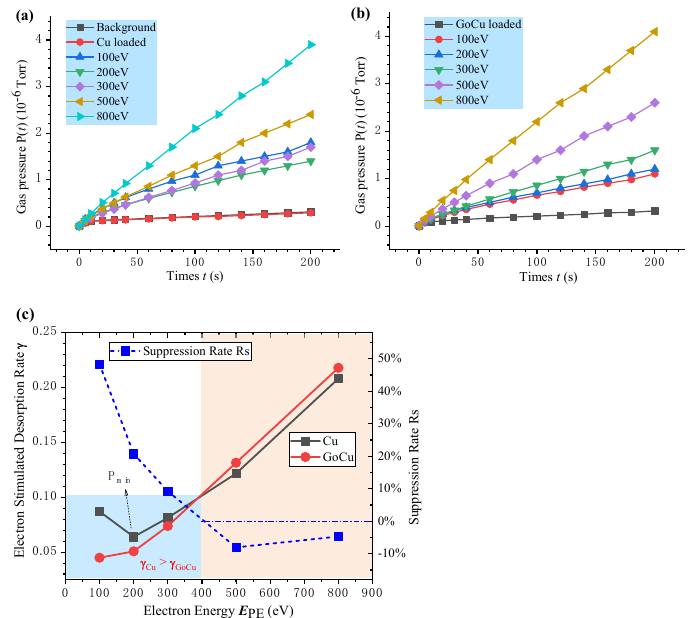
Figure 8. Variation of gas pressure as E-beam irradiation times for ( a ) Cu and ( b ) GoCu; ( c ) ESD rate and suppression rate on Cu and GoCu under different irradiation energy.